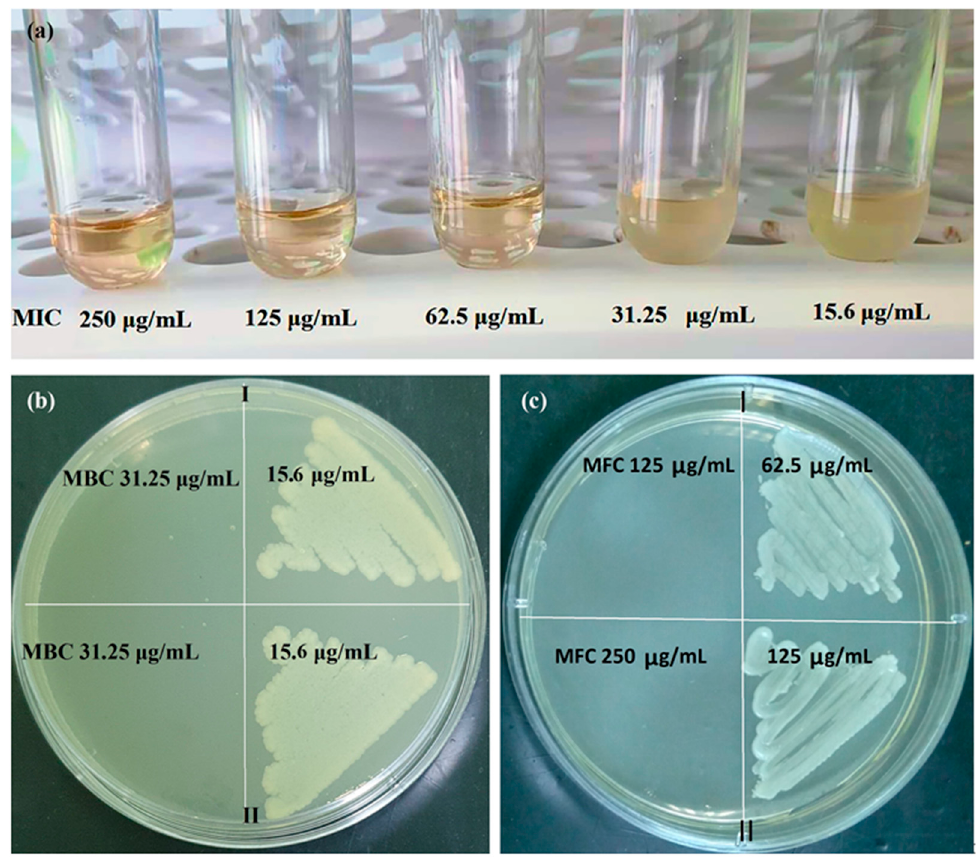
Figure 9. ( a ) MIC of PAAg for K. pneumoniae АТСС 700603 (EBSL); MBC and MFC of the water solutions freshly synthesized PAAg (I) and aged PAAg (II) for ( b ) E. coli ATCC 25922 and ( c ) C. albicans АТСС 90028, respectively. Table 1. Antimicrobial activity of freshly synthesized PAAg.